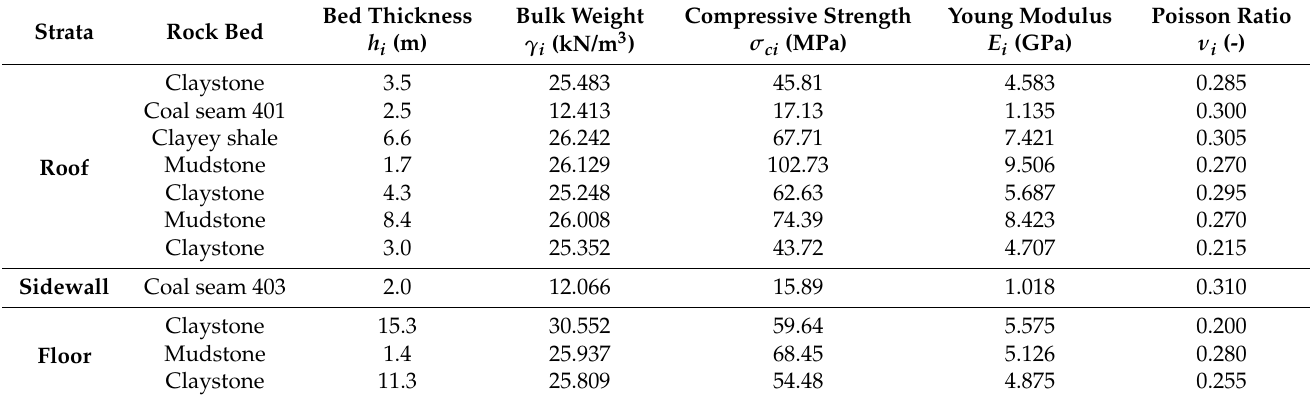
Table 3. Geomechanical parameters of rocks around roadway F-33.